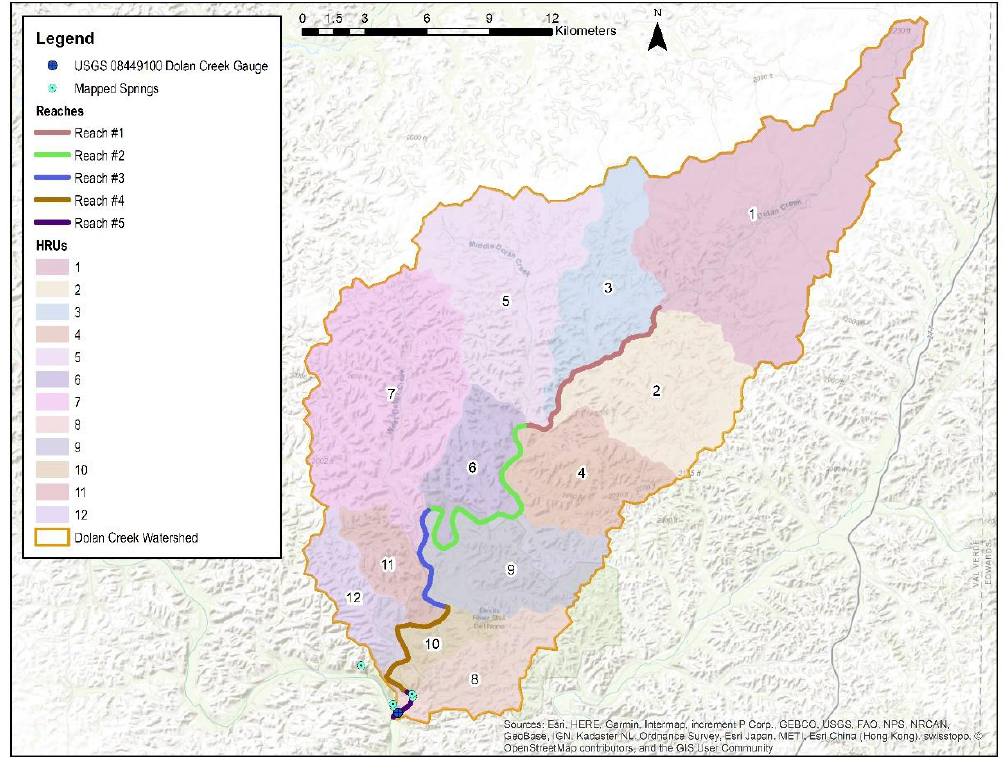
Figure 10. HSPF model configuration for Dolan Creek watershed. The watershed is represented with 12 hydrologic response units (HRUs). Dolan Creek is divided into five stream segments or reaches, RCHRES. Reaches #1–#4 are dry streambed areas that are considered to be losing reaches based on the Hydrologic Soil Type mapping from SSURGO [25]. Reach #5 provides the watershed outlet and is simulated as a gaining reach; it is assumed that no seepage or recharge occurs from this stream segment.